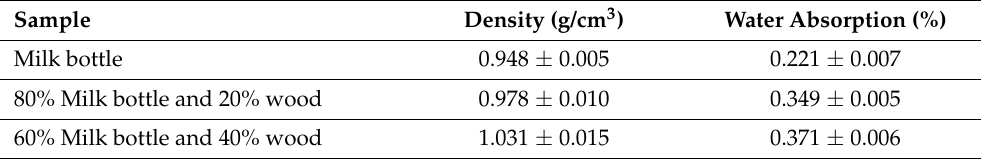
Table 2. The density and water absorption behavior of injection-molded